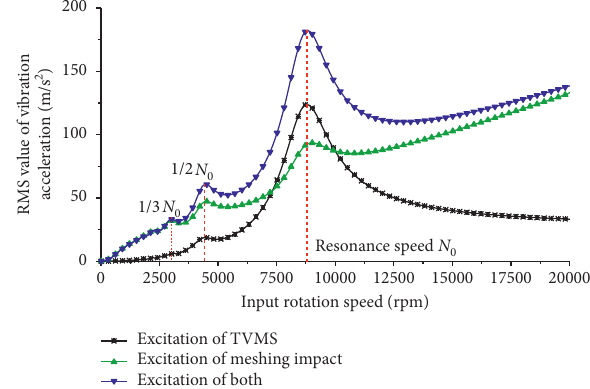
Figure 21: Vibration acceleration diagram for single-stage helical gear transmission